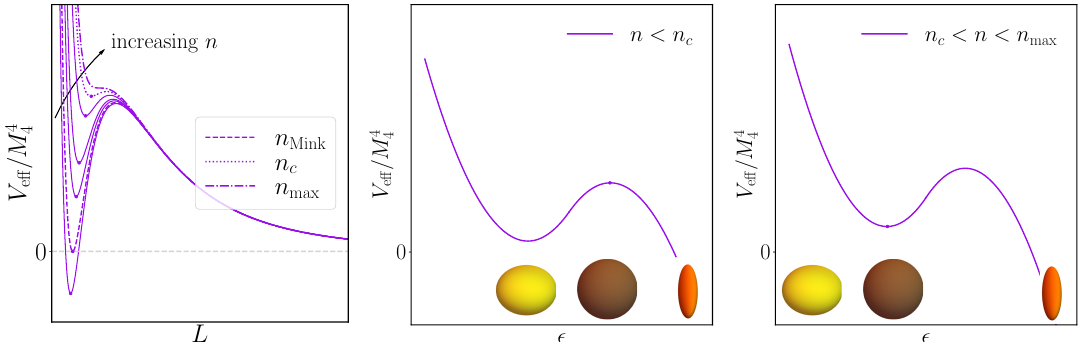
Figure 2 . Left: the effective radion potential eq. (2.36) for Λ D > 0 and successively larger values of n from bottom to top, assuming the compact space is spherically symmetric. The extrema correspond to the Freund-Rubin solutions. For small n , the effective potential has a maximum ( m 2 < 0 and always de Sitter) and minimum ( m 2 > 0 and de Sitter or anti-de Sitter). At ‘ =0 ‘ =0 n = n max the solutions disappear. Right: schematic of the effective potential for a fixed radius (minimum of V ( L ) ), but changing ellipticity. We find that the effective potential tends to + ∞ / −∞ eff as the internal manifold becomes increasingly oblate or prolate, respectively. The Freund-Rubin solution is at a maximum ( m 2 < 0 ) when the corresponding warped solution is oblate, and a ‘ =2 minimum ( m 2 > 0 ) when the warped solution is prolate. Some solutions escape the potential ‘ =2 well of oblate solution to roll in the prolate